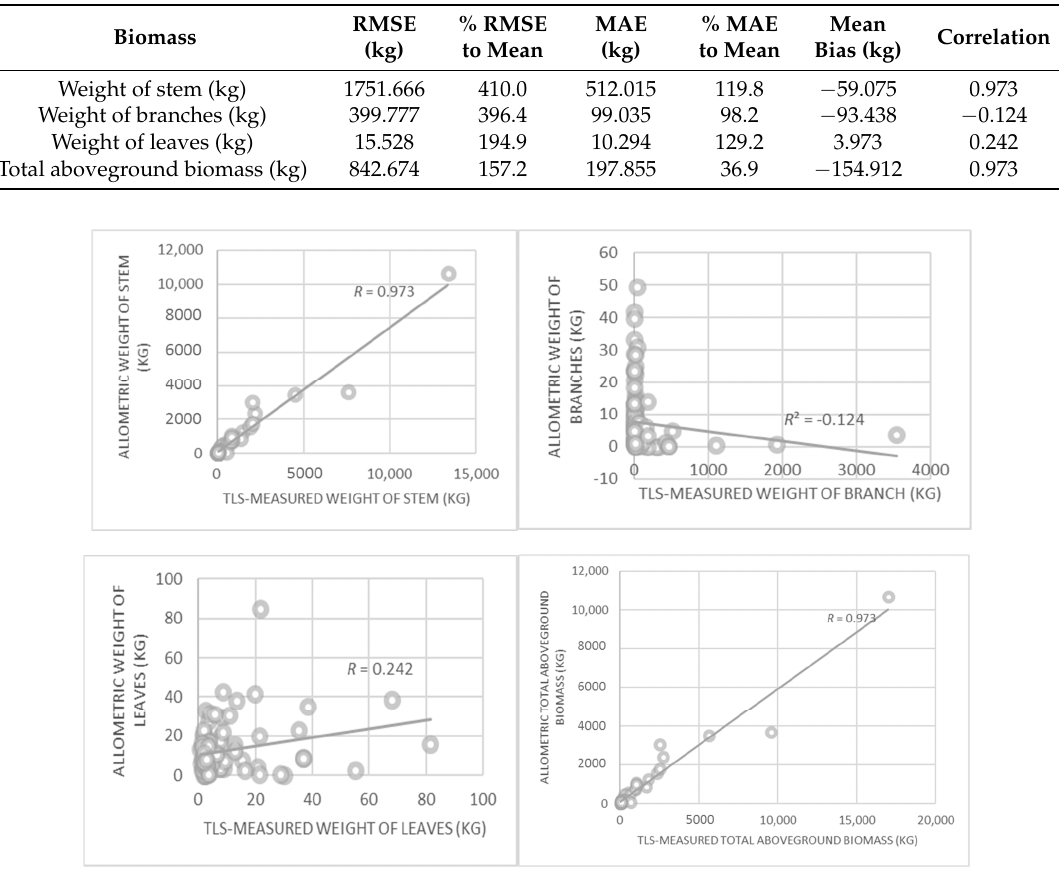
Figure 9. Alpha applied to the convex hull to refine the detail volume estimation for crown components. Table 3. Comparison of total above ground biomass (TAGB) and weight of stem, branches and leaves for all tree species between TLS-measured values and values obtained from allometric equations.